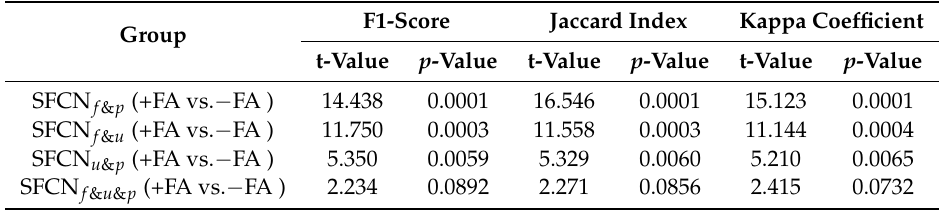
Table 4. Result of independent t -test of four SFCNs under with/without feature alignment. The p -value is the probability that SFCN has the same performances at both with and without feature alignment.